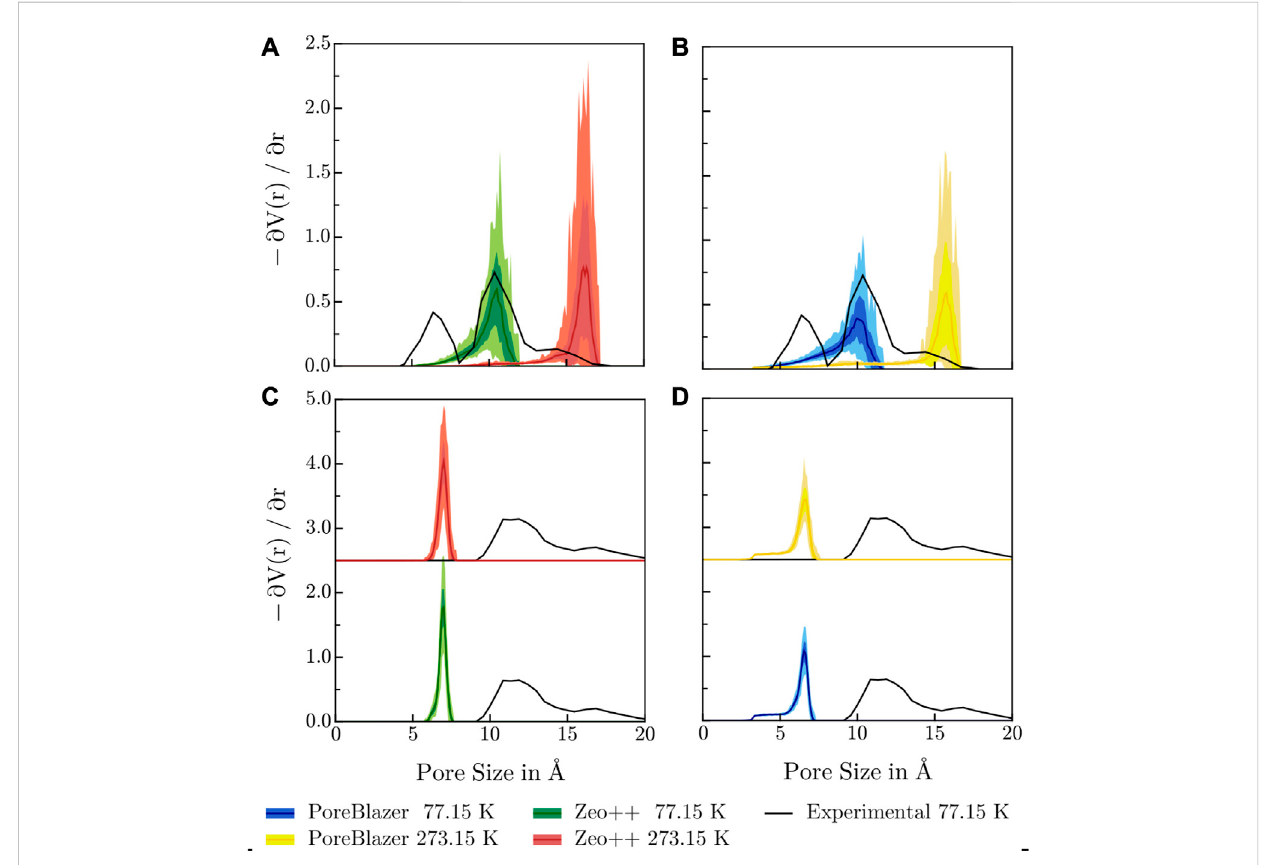
FIGURE 7 Comparison of the PSDs determined via the respective pore volume gradient as a function of pore radius, calculated with (A, C) Zeo++ and (B, D) PoreBlazer at77.15Kand 273.15 K with thePSD determined from adsorption experiments at77.15 Kfor (A, B) 3D-HNU5 and (C, D) HEX-COF1. The fi gure shows the calculated average μ enclosed by the interval μ ± σ , as well as the range of the y values for a given pore size [ y min , y max ] indicated via the color shading. For HEX-COF1, the PSDs at 273.15 K are shifted up, since the data at both temperatures are almost